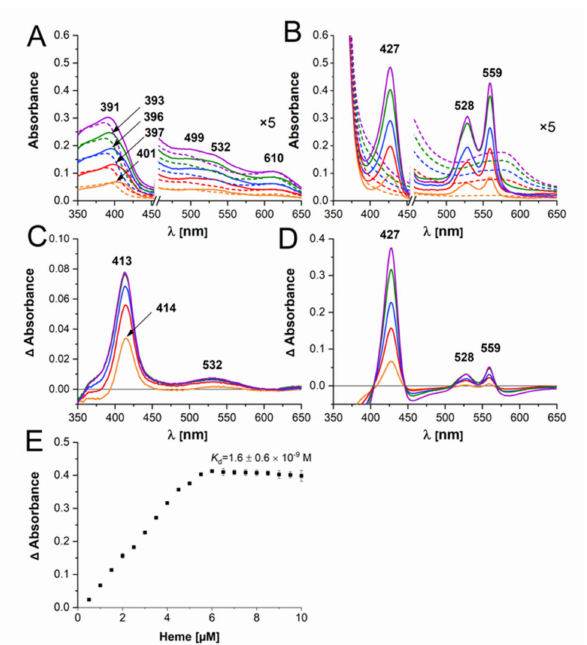
Figure 4. Spectroscopic analysis of heme binding to the purified Bvu protein. In the analysis, 5 µ M protein was titrated with heme under air (oxidizing) conditions ( A ) and subsequently reduced by sodium dithionite ( B ). Titration of Bvu with heme (solid lines) and buffer with heme (dashed lines) is shown ( A , B ). Spectra showing increasing concentration of heme or protein-heme complex are shown with different colors. Difference spectra examined under air (oxidizing) ( C ) and reducing conditions ( D ) are also shown. Spectra shown with different colors demonstrate increasing concentration of protein-heme complex after subtraction of heme-only spectra. ( E ) The curve was generated by titration of 5 µ M protein with heme by measuring the difference spectra between the protein + heme and heme-only samples under reducing conditions. Results are shown as mean ± SD from three independent